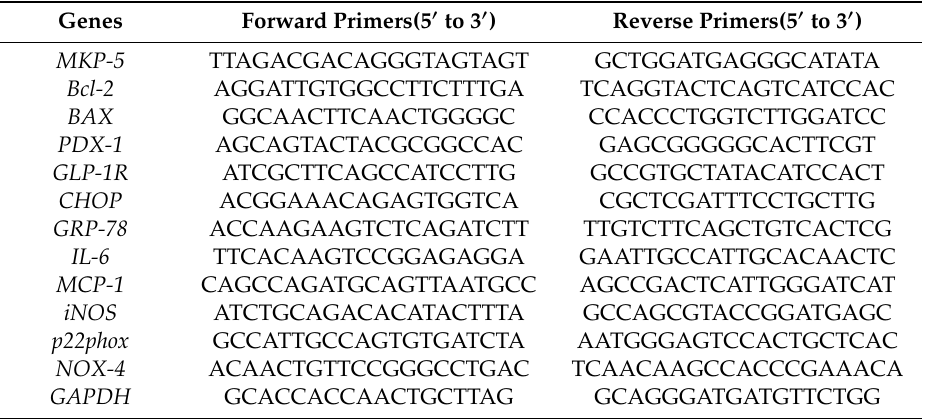
Table 1. Primers for quantitative Real-time PCR. Genes Forward Primers(5 (cid:48) to 3 (cid:48)